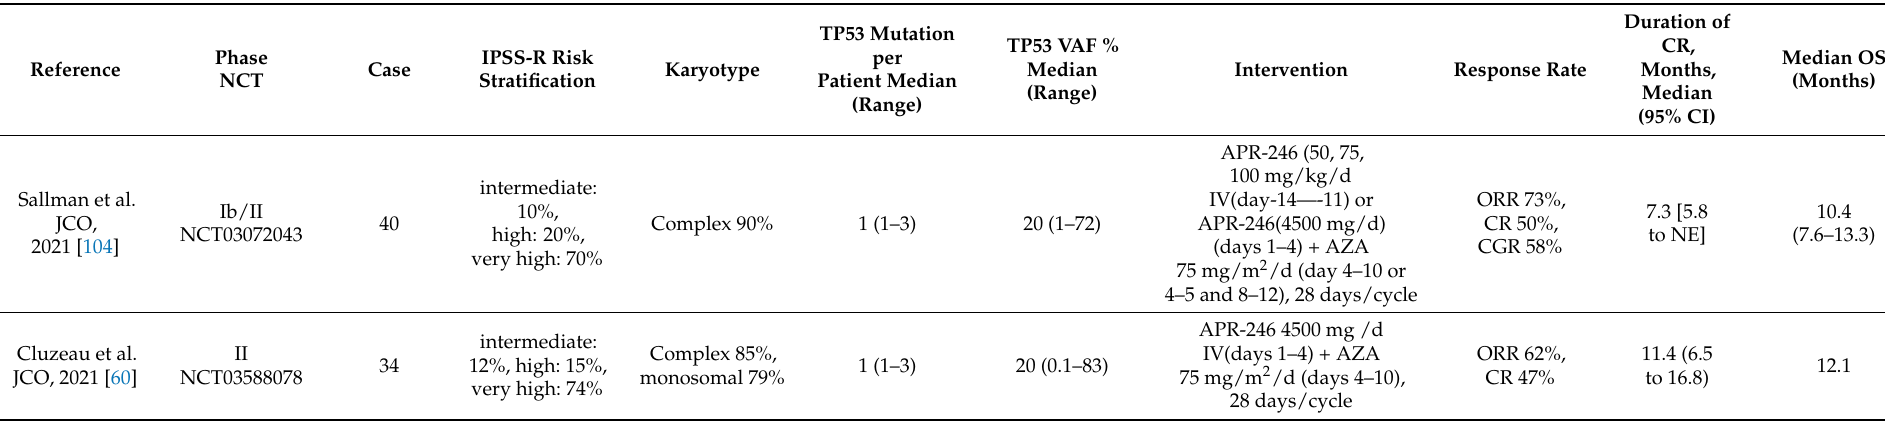
Table 1. Two studies evaluating the efficacy and safety of APR-246 in combination with azacitidine in MDS patients with TP53 mutations.